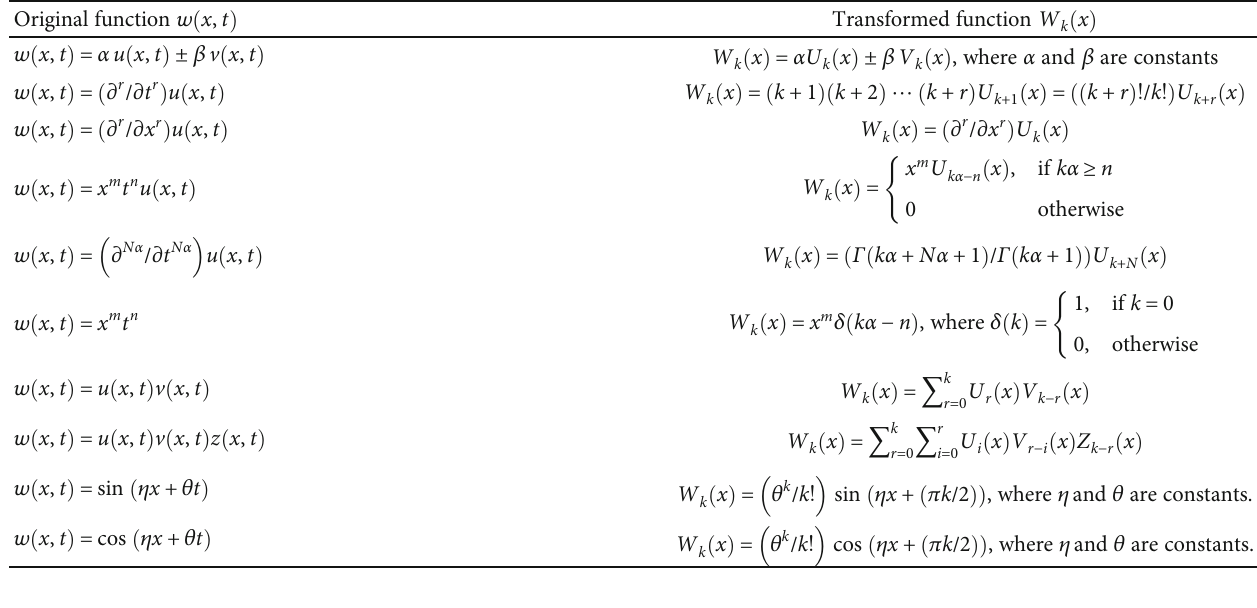
Table 3: Basic operations of the fractional reduced di ff erential transform method [3, 34, 36, 37].